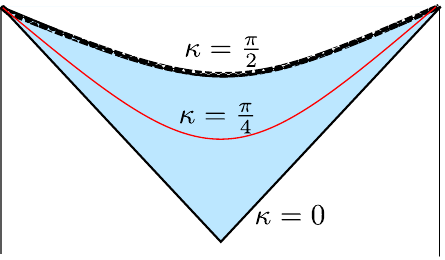
Figure 4 . The top part of the Penrose diagram of the eternal wormhole with the location of the horizon, the maximal in(cid:12)nite time Cauchy slice and the singularity highlighted in the coordi- nates (5.2). The blue region is the top interior, and also the WDW patch of the red